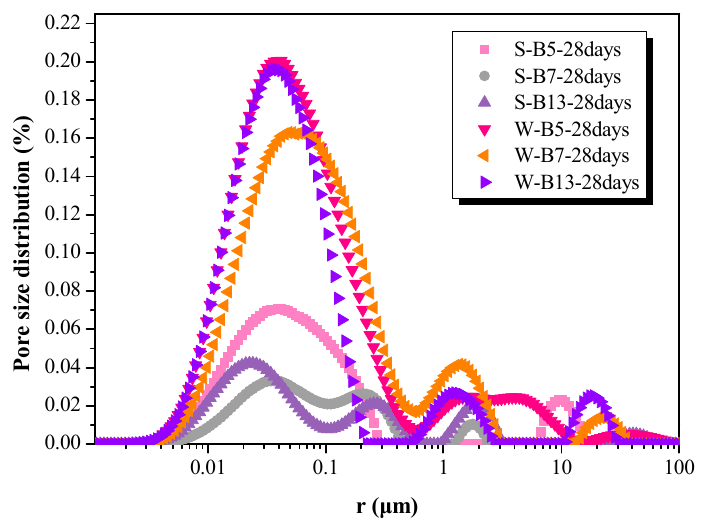
Figure 8. Pore size distribution of AA-FASM under seal- and water-saturation-curing conditions.